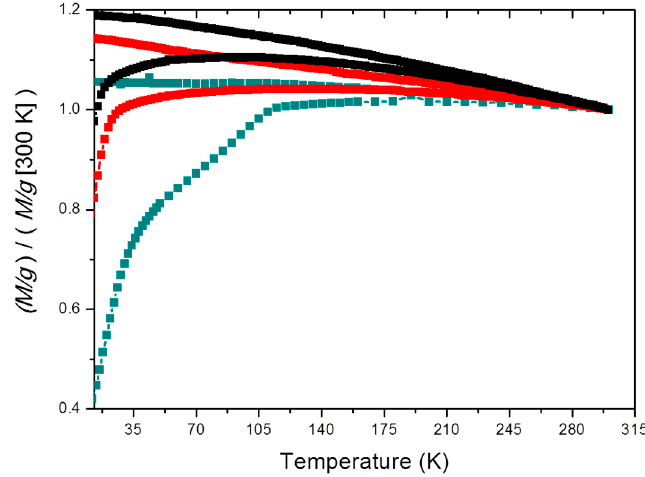
Figure 4. Zero field cooling-field cooling (ZFC-FC) curves at 40 kA/m of MNPs ( ■ ), BMNPs ( ● ) and 25 B + 75 M ( ♦ ).